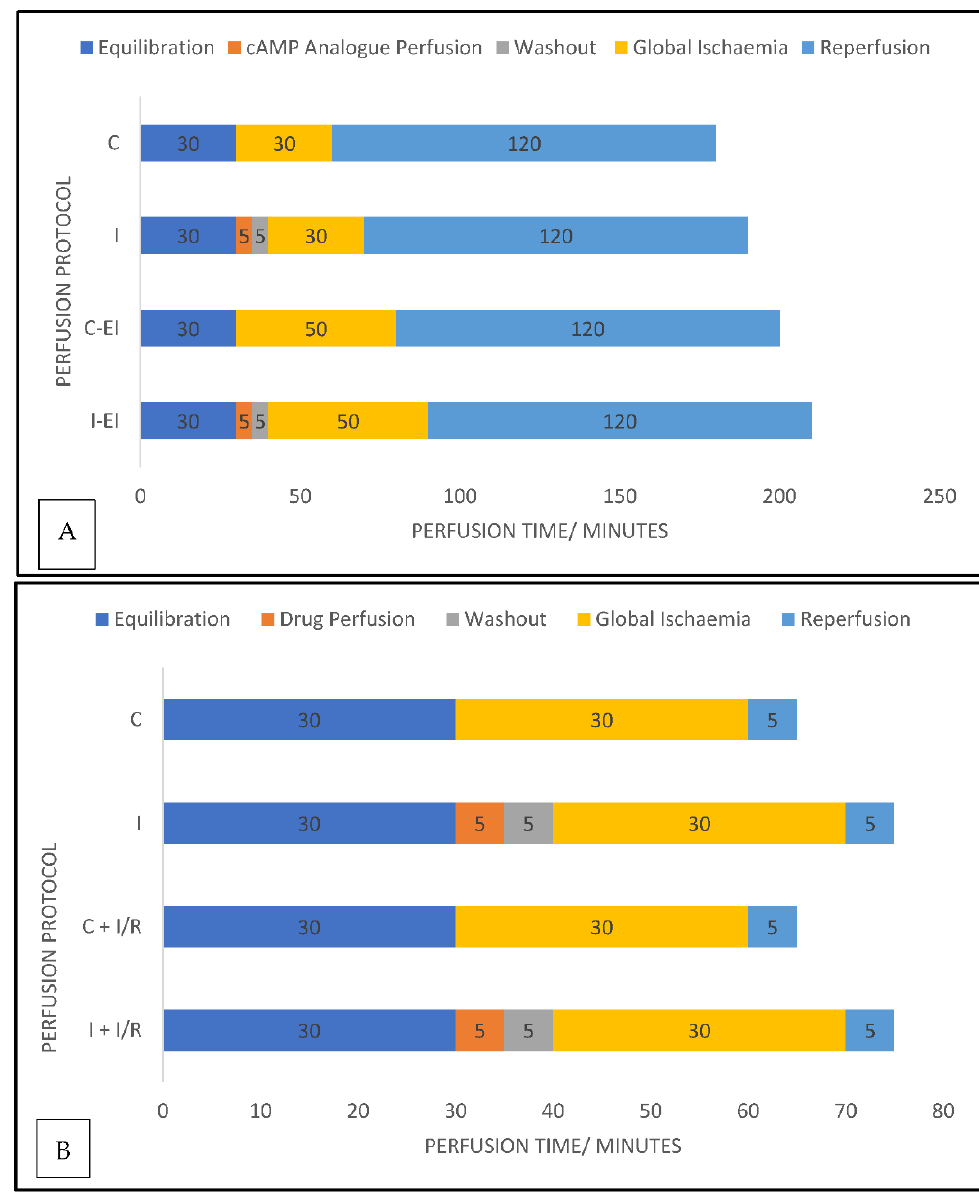
Figure 1. Perfusion protocols for experimentation. Graphical representations of the experimental protocols used for ex vivo heart perfusion in experiments measuring ( A ) CK activity and area of infarct size in experiments and ( B ) experimental protocols for mitochondrial isolation experiments Data labels are the durations, in minutes, of each phase of the protocol. Colour blocks indicate the phases of the experiment; blue = standard perfusion with Krebs Henseleit (KH) buffer; orange = perfusion with KH containing a drug; grey = drug washout period. C = control group; I = intervention group; EI = extended ischaemic time; I/R = ischaemia/reperfusion.